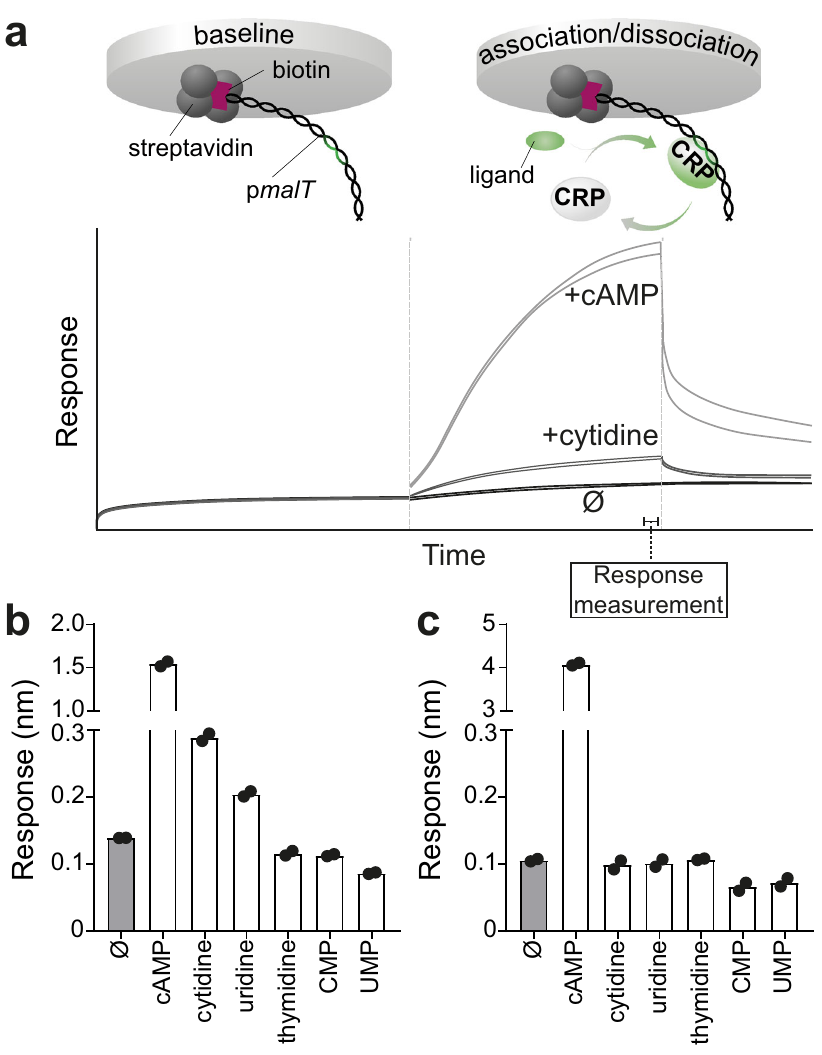
Fig. 4 In vitro activity of Crp and CrpA144T using biolayer interferometry. a Upper panel: Illustration of biolayer interferometry where a biosensor coated with streptavidin binds to biotinylated DNA encoding the Crp-responsive P malT promoter, and produces a signal when associating and dissociating with the Crp protein depending on the ligand present. Lower panel: Representative output showing the progression of output (nm) aligned to baseline. Data correspond to part of the data in panel 2b, in the absence of ligand (Ø), with the positive control cyclic adenosine monophosphate (cAMP) or with cytidine. b Association of CrpA144T to P malT in the presence of pyrimidines (10 mM) or the positive control cAMP (0.5 mM). CMP, cytidine monophosphate; UMP, uridine monophosphate. Absence of ligand (Ø) serves as a negative control. c Association of wildtype Crp to P malT in the presence of different pyrimidines, the positive control cAMP (white) or no ligand (grey, Ø). Data represent the average of two